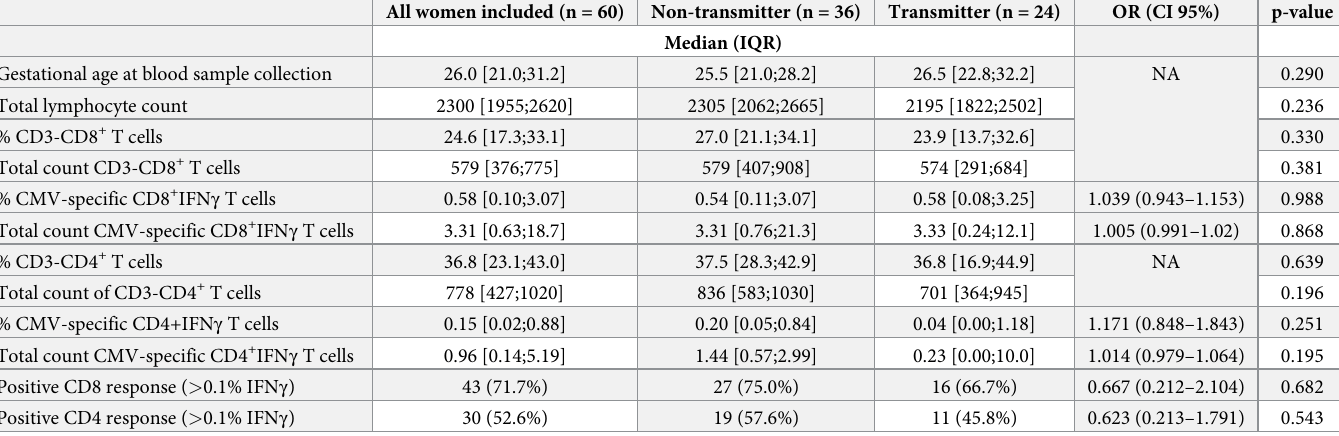
Table 2. Results of the bivariate analysis of the T-cell immune response in women with a primary CMV infection.